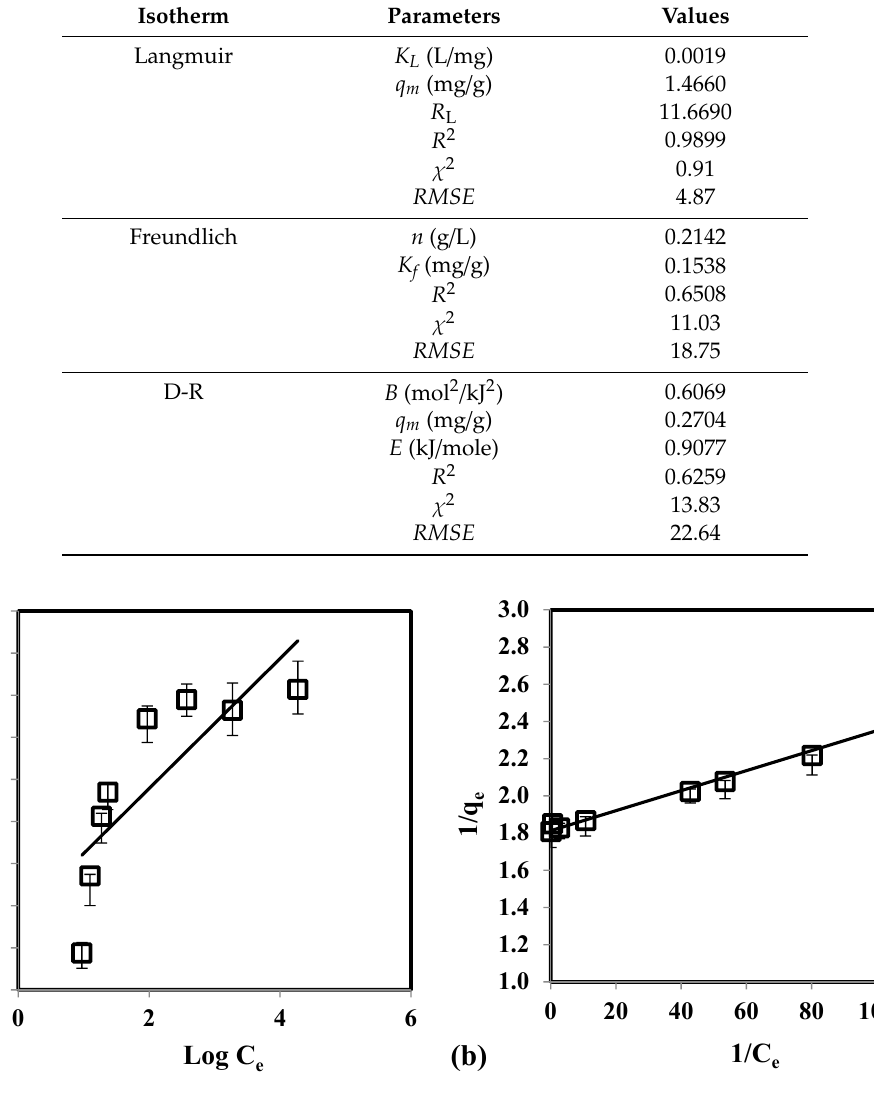
Table 3. List of isotherm parameters for the removal of As(V) using CCB.